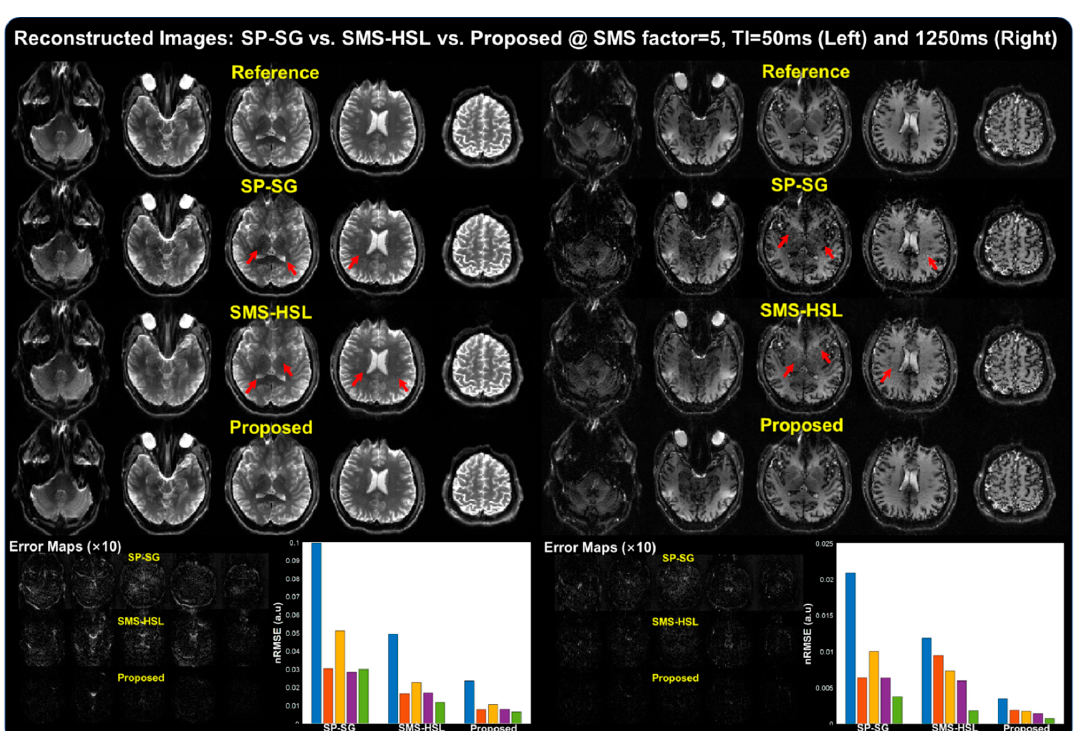
Figure 3. Images, error maps, and nRMSEs generated using SP-SG, SMS-HSL, and our proposed method at an SMS factor of 5 according to different contrasts (TIs = 50 ms and 1250 ms). SP-SG suffers from severe noise (third slice) and aliasing (fourth slice) due to the ill-conditioning of the inverse problem while SMS-HSL mitigates the artifacts with generalized null space kernels. Finally, our proposed method gives the best reconstruction results, owing to the lower rank of the Hankel-structured matrix. The visual quality looks similar for different Tis (Figure S1).